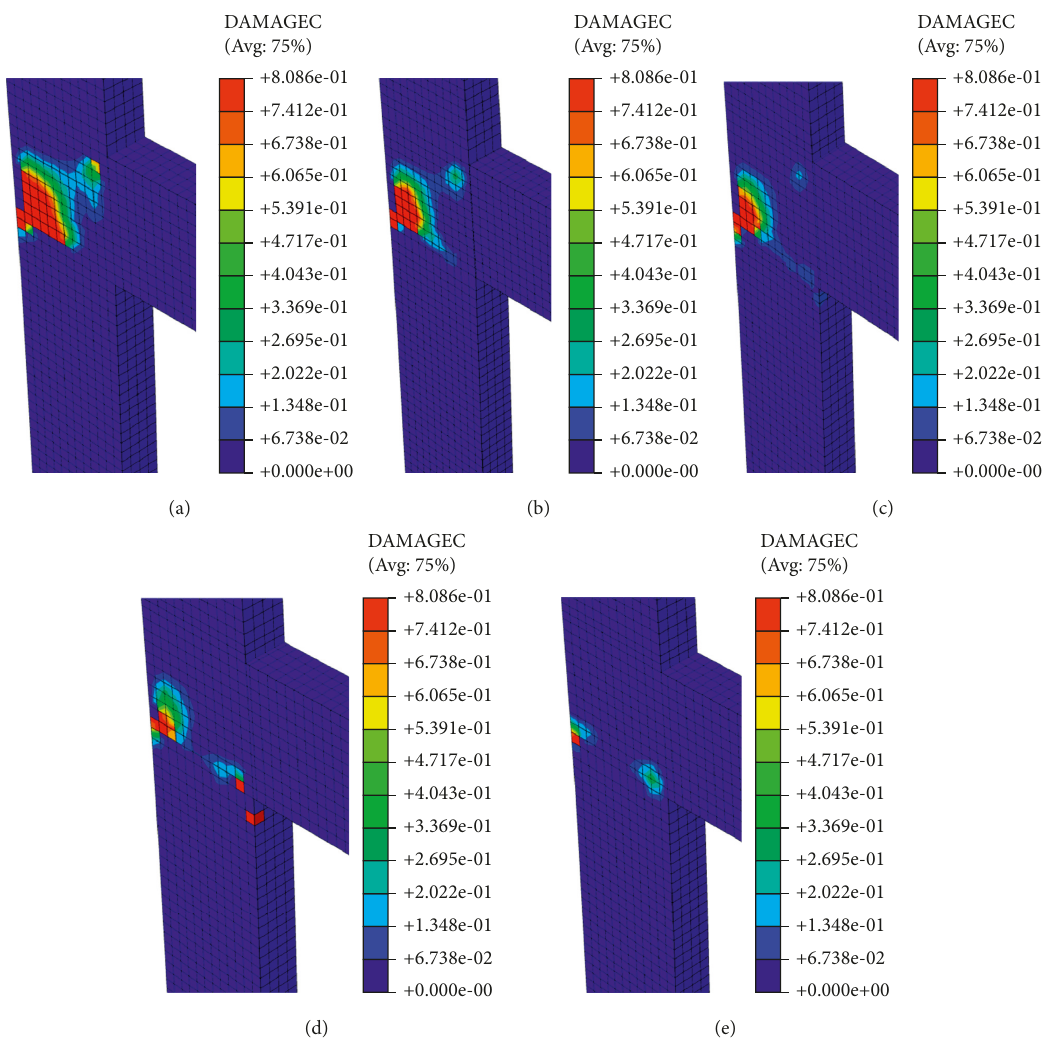
Figure 25: Concrete compression damage for specimens with various thicknesses of TRC: (a) G4M0, without TRC; (b) Referential, 0.003m; (c) G4M1, 0.006m; (d) G4M2, 0.01m; and (e) G4M3, 0.02